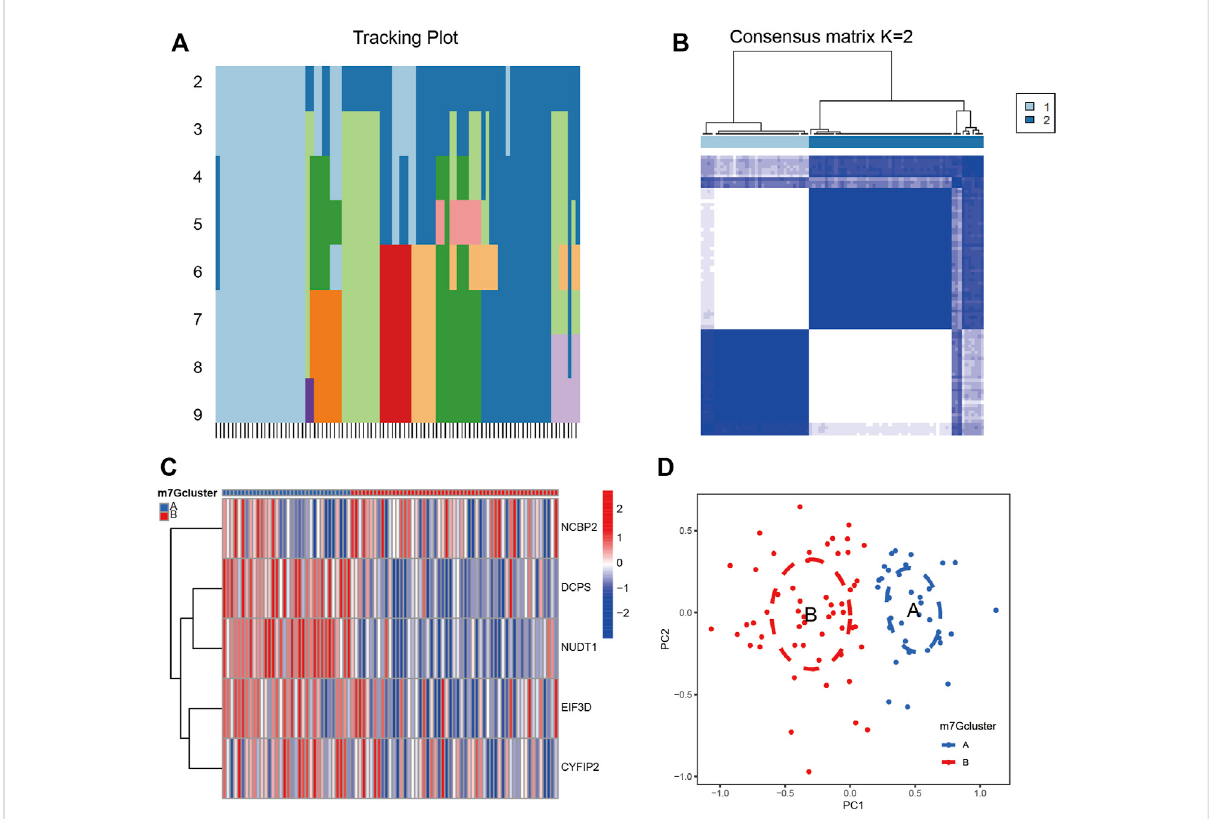
FIGURE 4 Cluster analysis of IS by m7G key regulatory genes. (A) Sample distribution for k = 2 – 9. (B) Consensus clustering matrix with k = 2. (C) Heatmap of m7G key regulatory genes between clusters. Red represents high expression and blue represents low expression. (D) PCA analysis between clusters. Group A and group B represent two clusters of IS patients divided according to the expression of m7G key regulatory genes. PCA: principal component